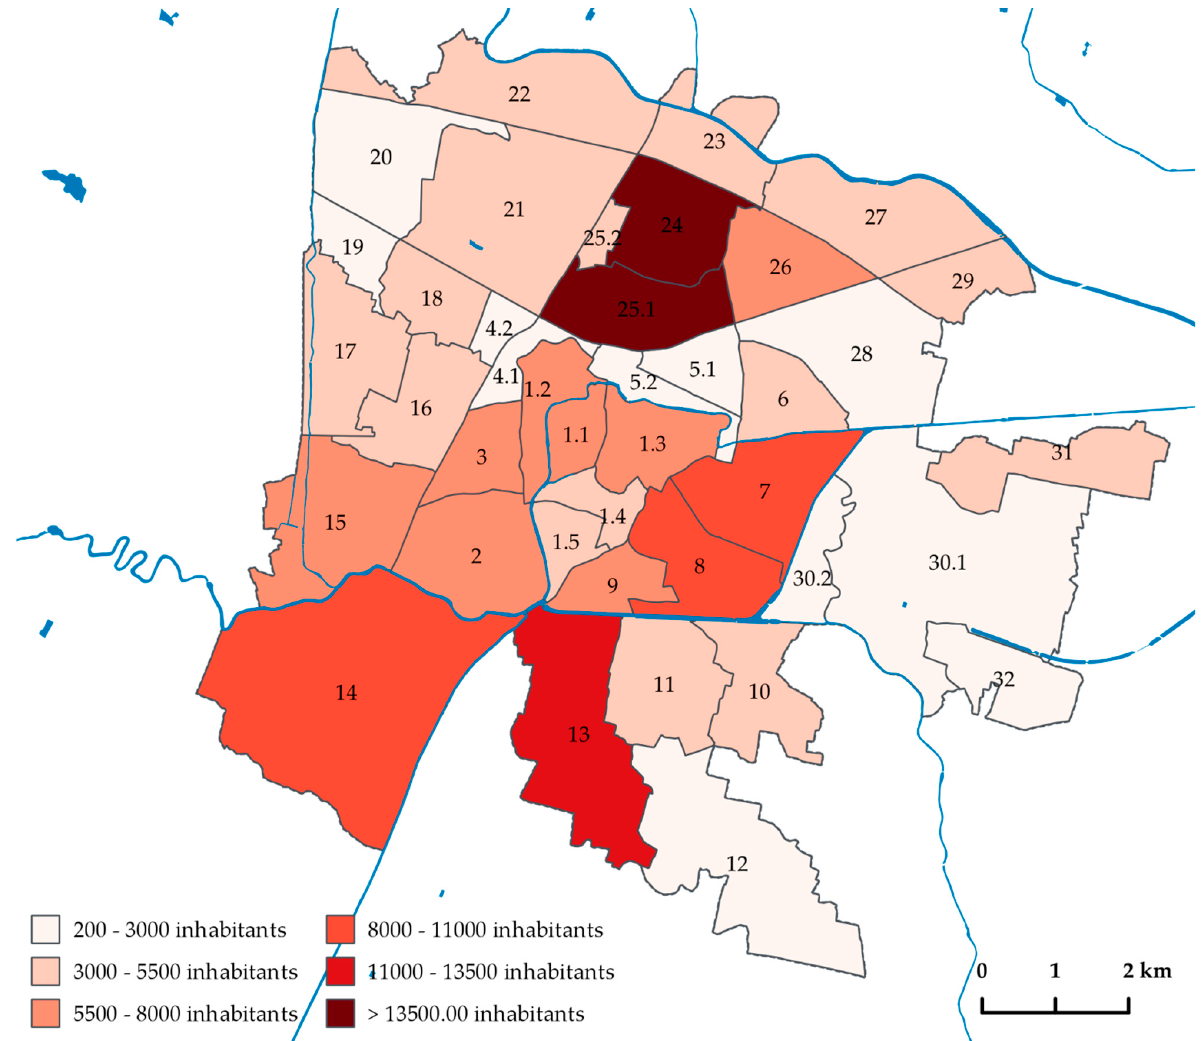
Figure 11. Population in Padua urban units. Urban units are represented in the map by their municipal codes (see Table 11 for the corresponding urban units).